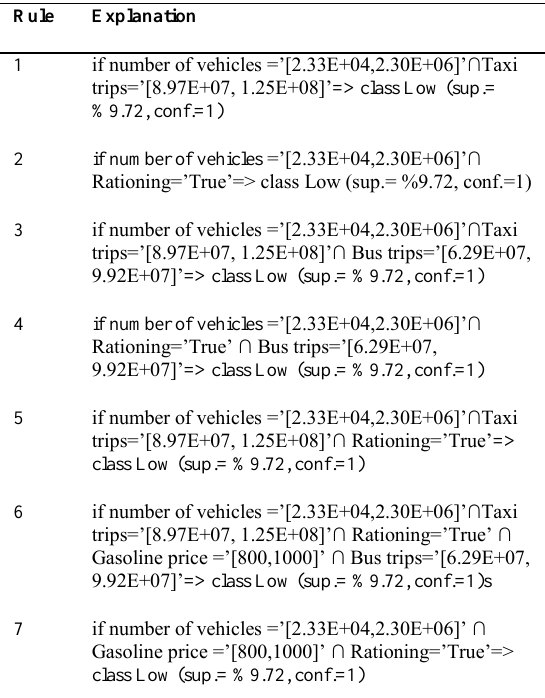
Table 5. Extracted rules for low gasoline consumption by Apriori